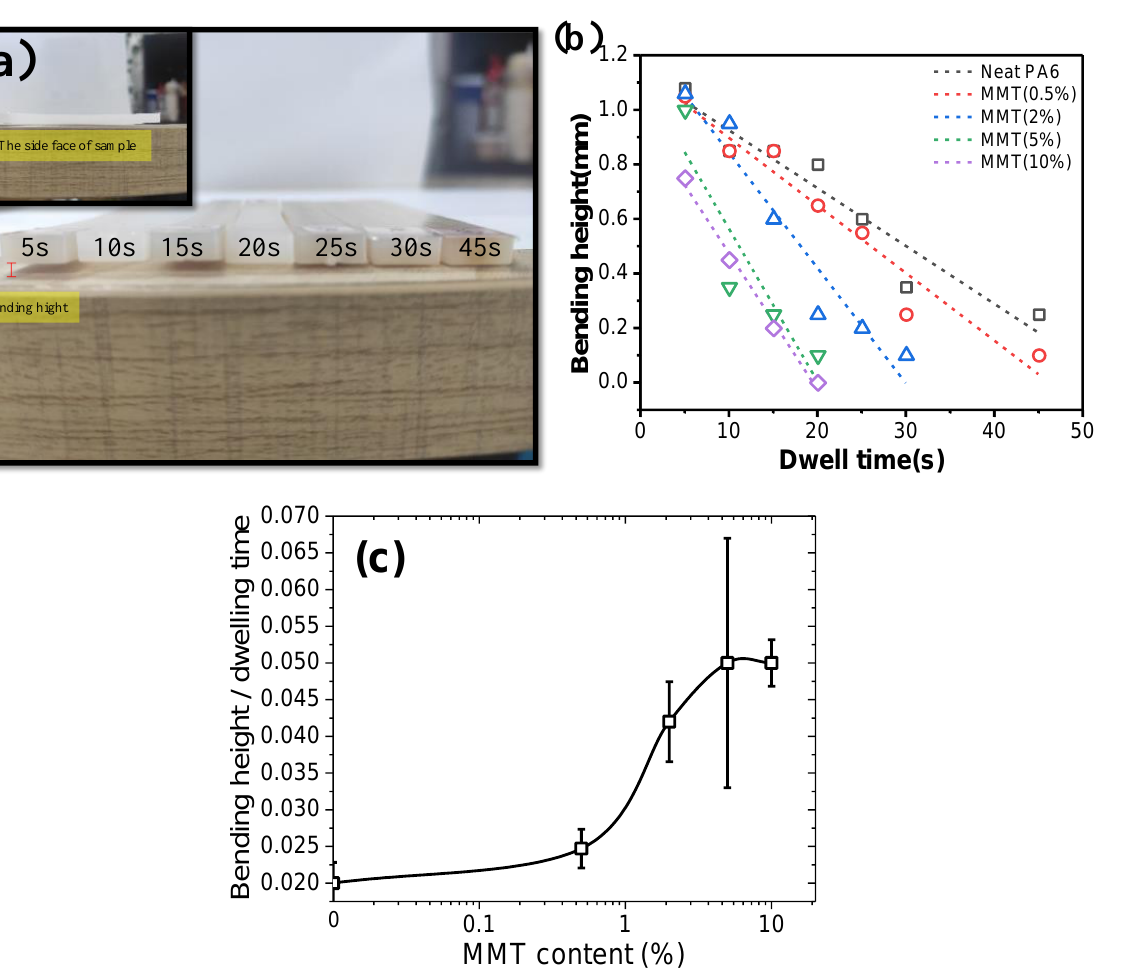
Figure 1. ( a ) Images of neat nylon 6 sample during bending height experiments; ( b ) Bending height as functions of molding dwelling time of nylon 6 and nylon 6/montmorillonite composites with different montmorillonite loadings; ( c ) The ratio of bending height and dwelling time vs. MMT contents. Here we take the curve slope of bending height vs. dwelling time to represent the solidification speed of nylon 6/MMT composites. As shown in Figure 1c, with increasing MMT content, the solidification speed increases slowly with MMT content, and then a step change occurs at around 2 wt% of MMT content and levels off at around 10 wt% of MMT contents. Overall, the addition of MMT into nylon 6 speeds up the solidification process and the lowering the molding cycle, which increases the molding efficiency and benefits the economical process. However, it is unclear why this happens and why there is such a step change of solidification speed at a MMT composition of 2